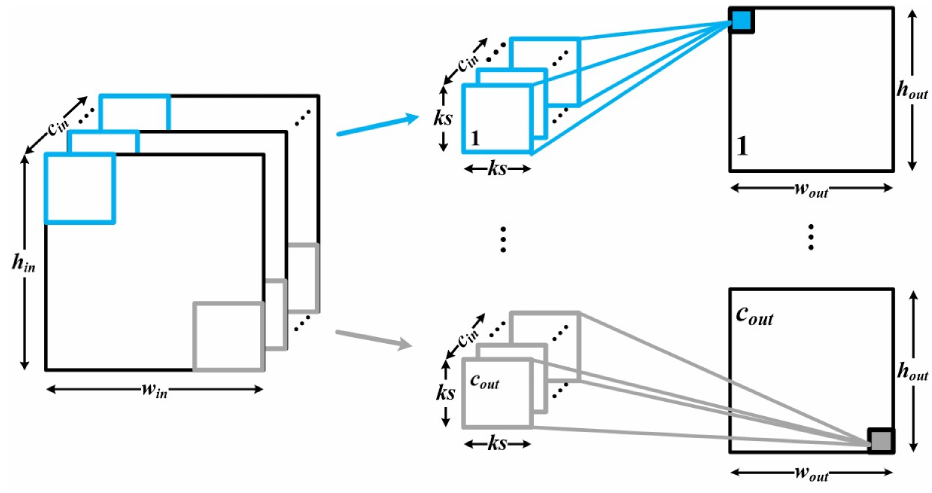
Figure 1. High-dimensional convolutions in